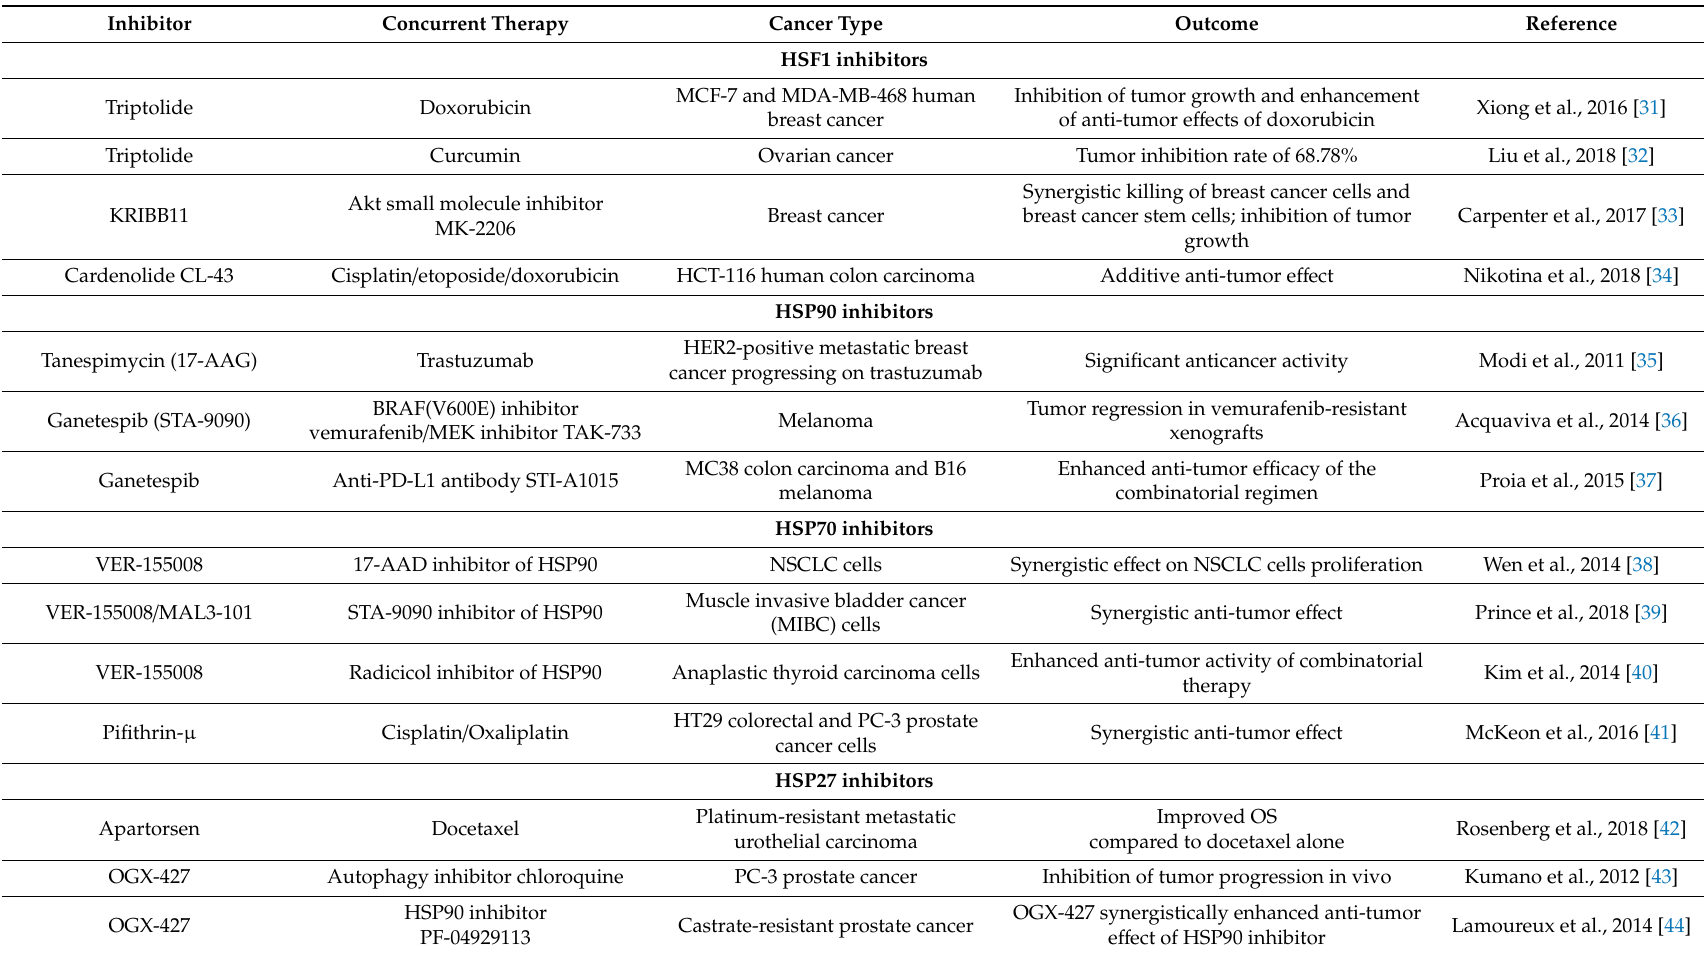
Table 2. Concurrent anti-tumor therapies employing inhibitors of